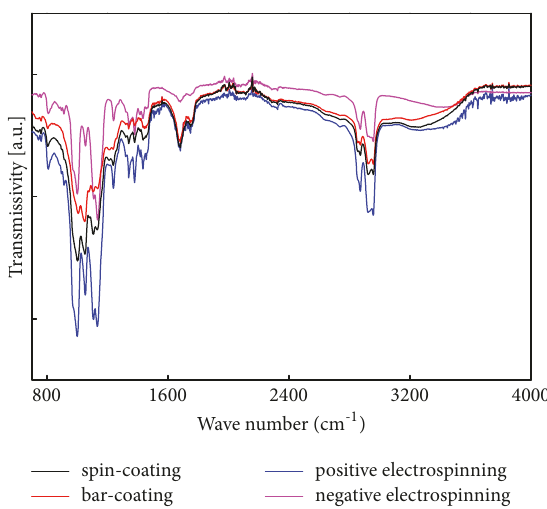
Figure 1: FTIR spectra of PVB films made by different methods.